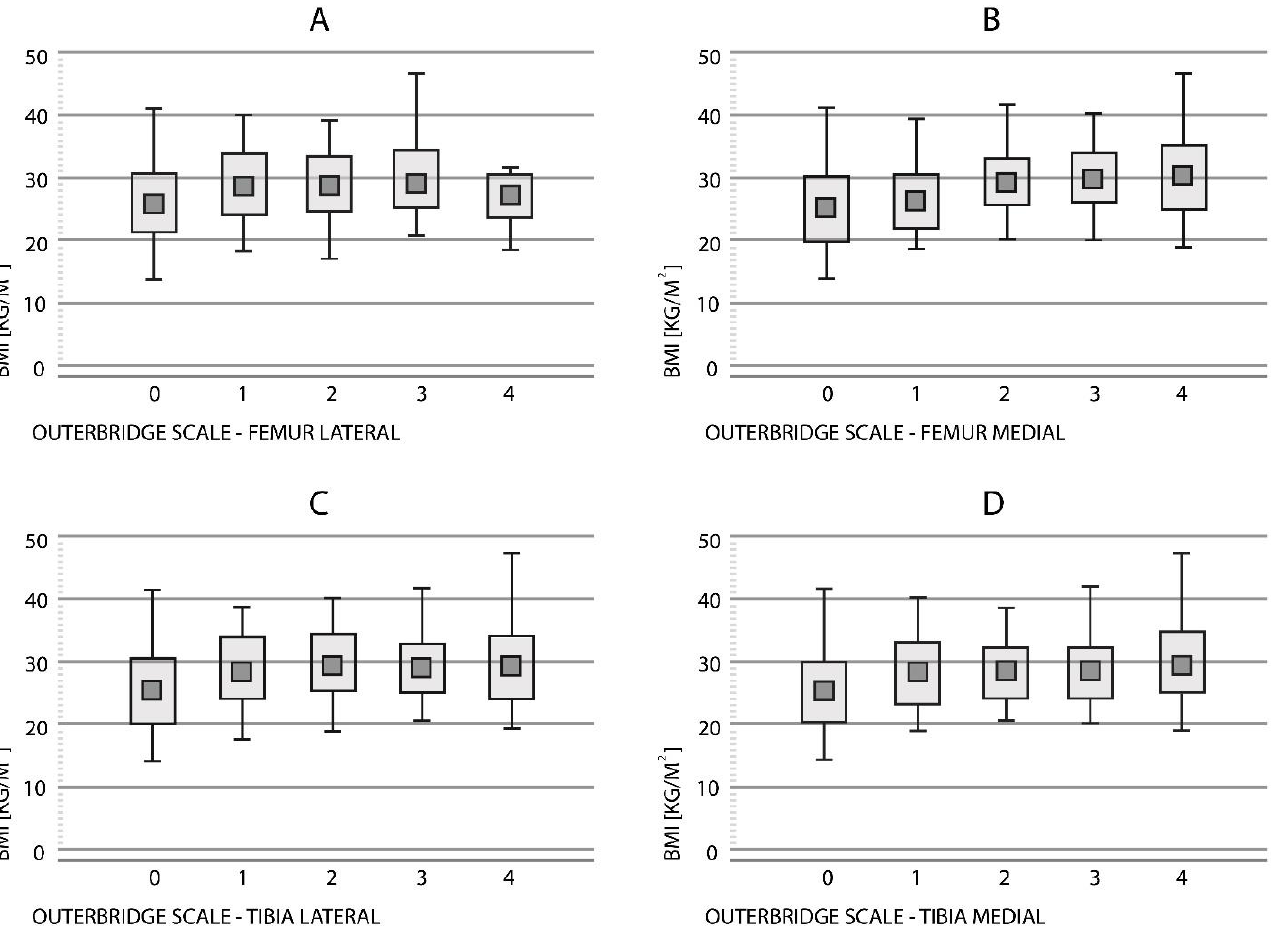
Figure 2. Relationship between BMI and Outerbridge scores using both scanners (1.5T and 3.0T) in the entire study group for femur lateral ( A ), femur medial ( B ), tibia lateral ( C ), and tibia medial ( D ). There was a statistically significant difference in BMI level according to the Outerbridge parameter score (KW, p < 0.001) in the entire study group of patients (scanner 1.5T and 3.0T). For the femur lateral, there were no significant statistical differences between the Outerbridge subgroups (1 and 2 vs. 3 and 4) in terms of the BMI level (U-test, p =